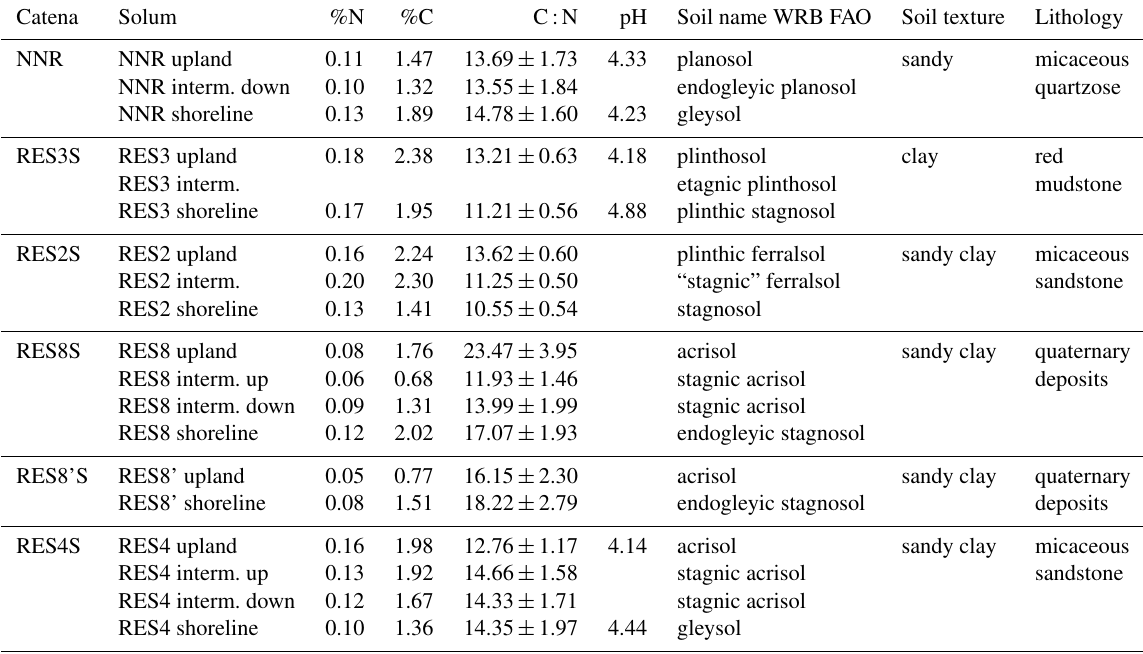
Table 1. Soil type and characteristics at the sampling station of the drawdown area of the Nam Theun 2 Reservoir (Lao PDR). KKK formation. Catena Solum %N %C C : N pH Soil name WRB FAO Soil